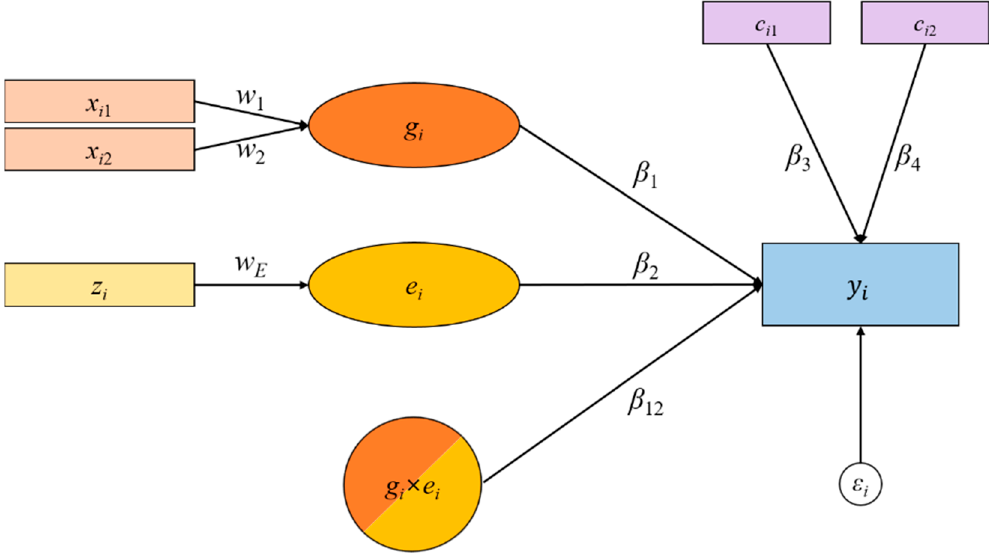
Figure 2. A schematic diagram of Hierarchical structural CoMponent analysis of gene-based Gene–Environment interactions (HisCoM-G × E). The exemplary model is described with the number of single nucleotide polymorphisms (SNPs) ( x ik ) K = 2 and the number of covariates ( c ip ) P = 2. The variables ws denote the weights assigned to the latent variables and β s are coefficients of the latent variables ( g i and e i ). The g i × e i term represents a latent interaction term (or effect) on the phenotype ( y i ) and ε i is the error term.